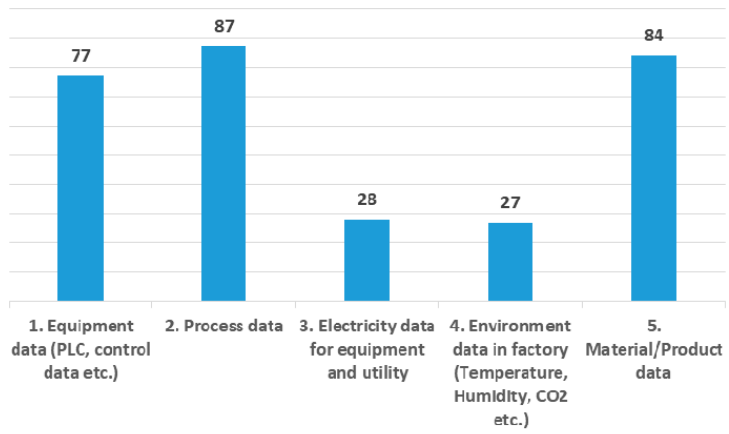
Figure 6. Desired data to be acquired and managed.